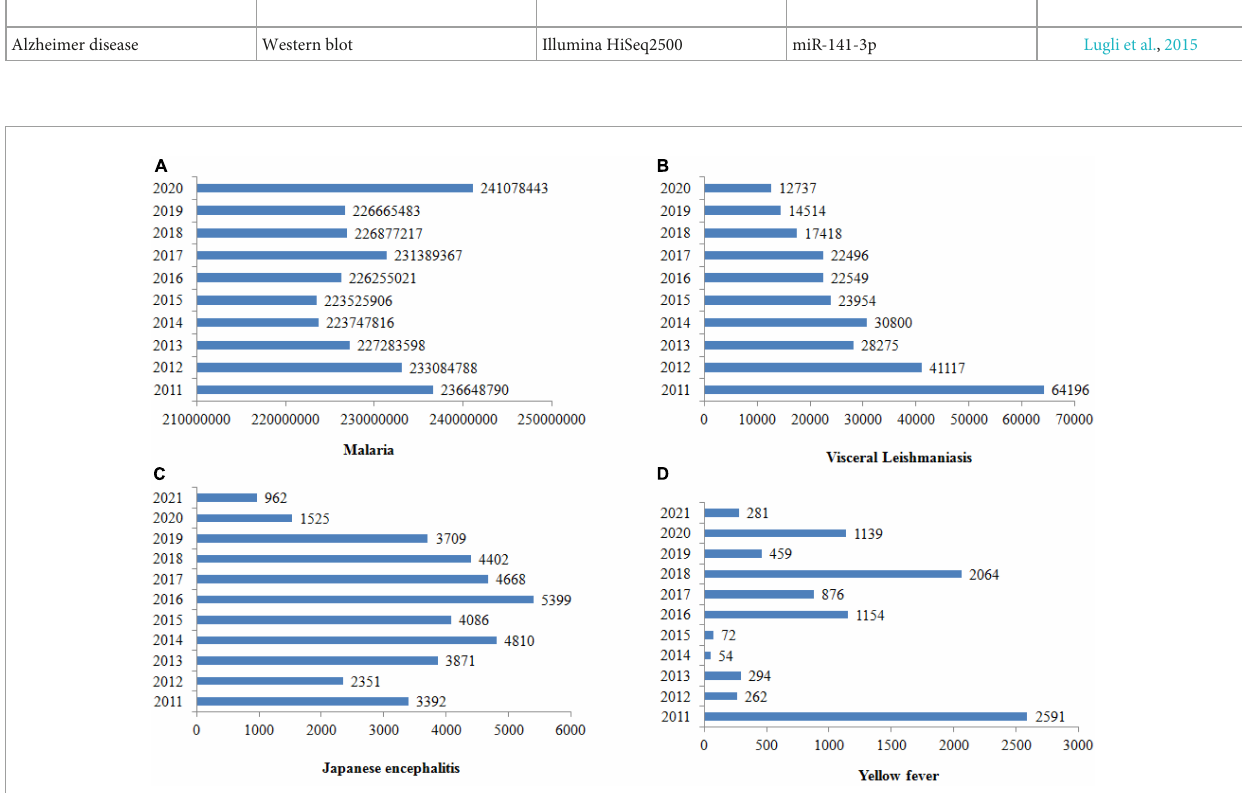
FIGURE1 Cases of vector-borne diseases worldwide from 2011 to 2020. The prevalence of malaria is rising, but leishmaniasis, Japanese encephalitis and yellow fever seem to be declining (World Health Organization, 2020a,b, 2021, 2022d).